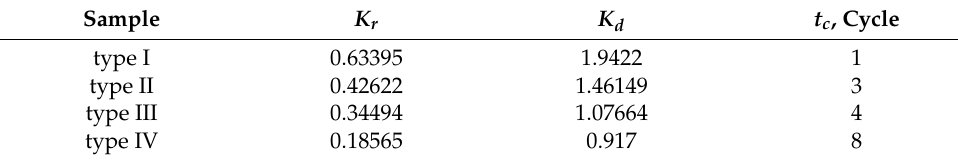
Table 5. Corrosion potential ( E corr ) and current ( I corr ) of samples with different oxide scales. Sample